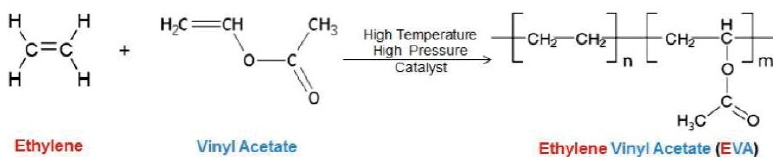
Figure 8. Synthesis scheme of the synthesis of ethylene vinyl acetate (EVA) copolymer [72].